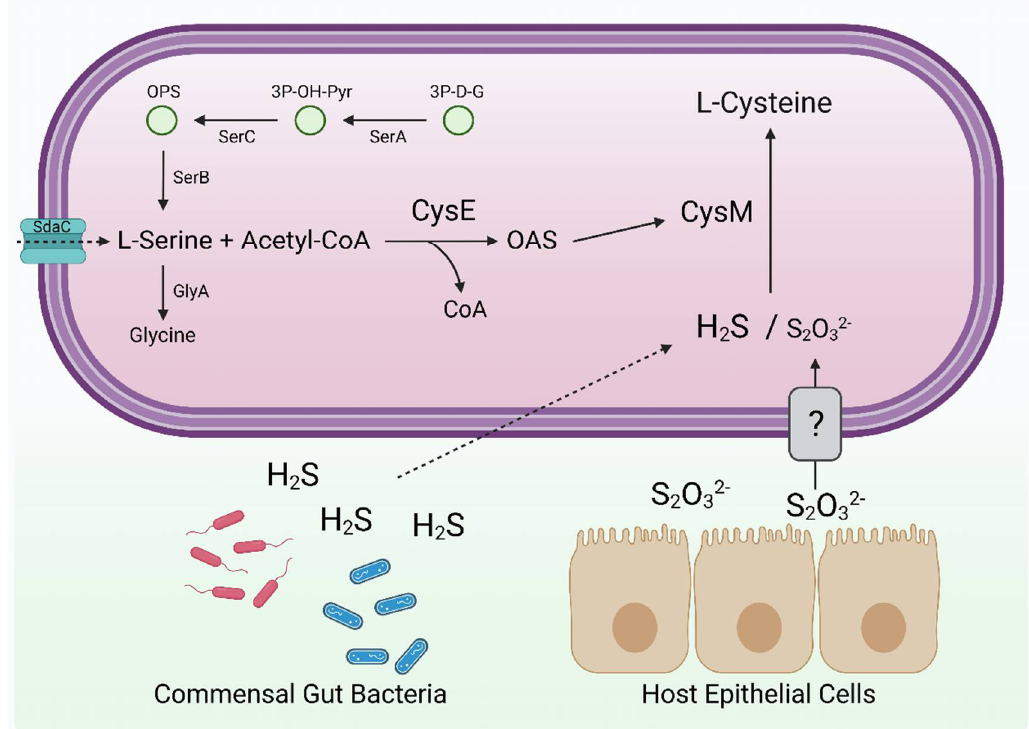
Figure 9. Model for cysteine synthesis in C. jejuni : C. jejuni cysteine synthase (CysM) exclusively utilises OAS as sulfur acceptor, which is generated by CysE in an acetyl-CoA dependent reaction from L-Serine. L-Serine can be directly imported from the environment by the transporter SdaC, or endogenously synthesised from 3-Phospho-D-Glycerate (3P-D-G) by SerABC. CysM can utilise both sulfide and thiosulfate as sulfur donors, although the C. jejuni enzyme has a clear enzymatic preference for sulfide. Both are abundant in the gut; sulfide is generated from host microbiota and thiosulfate by host epithelial cells. Hydrogen sulfide can freely diffuse across membranes while thiosulfate requires active transport. ?: thiosulfate transporter, yet to be identified in C. jejuni . Figure created with BioRender.com.